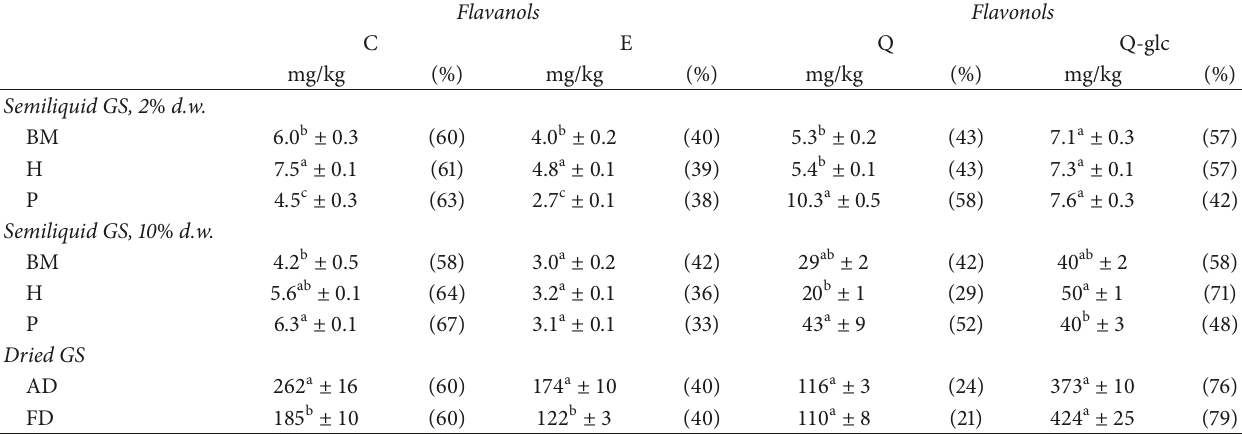
Flavanols Flavonols